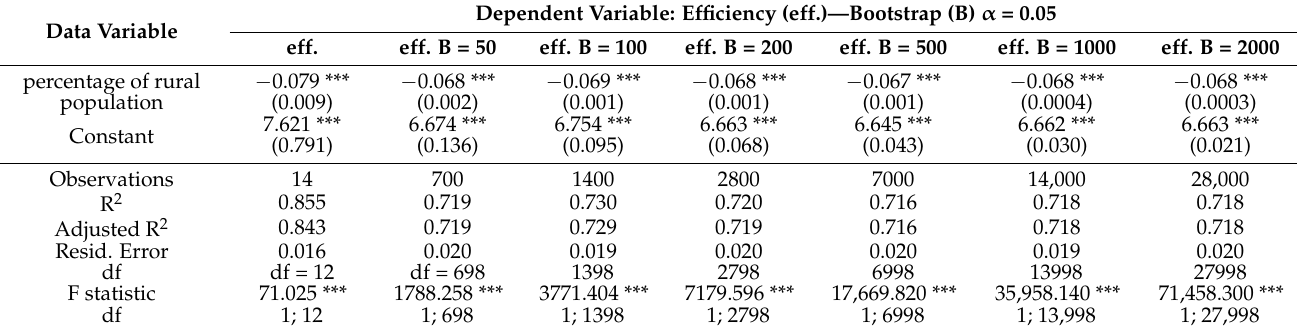
Table 13. Results for regression analyses of bootstrap